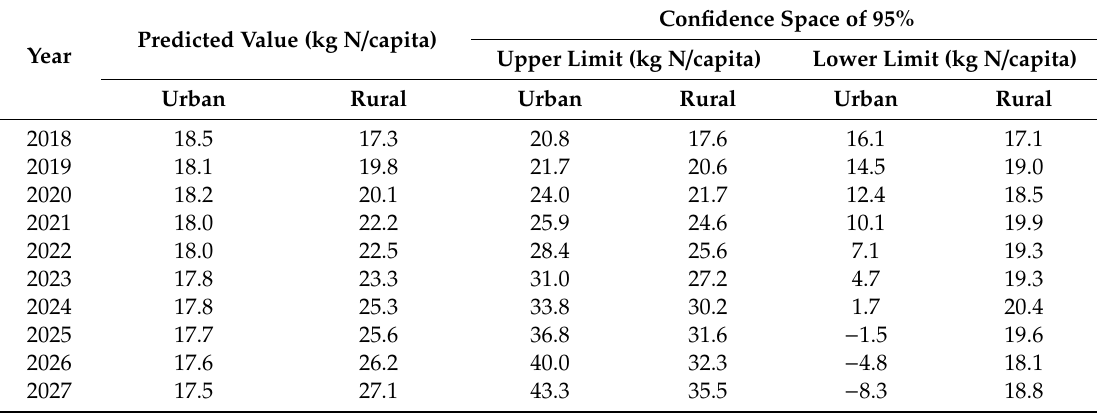
Table 4. Predicted value of food N footprints in Shanghai from 2018 to